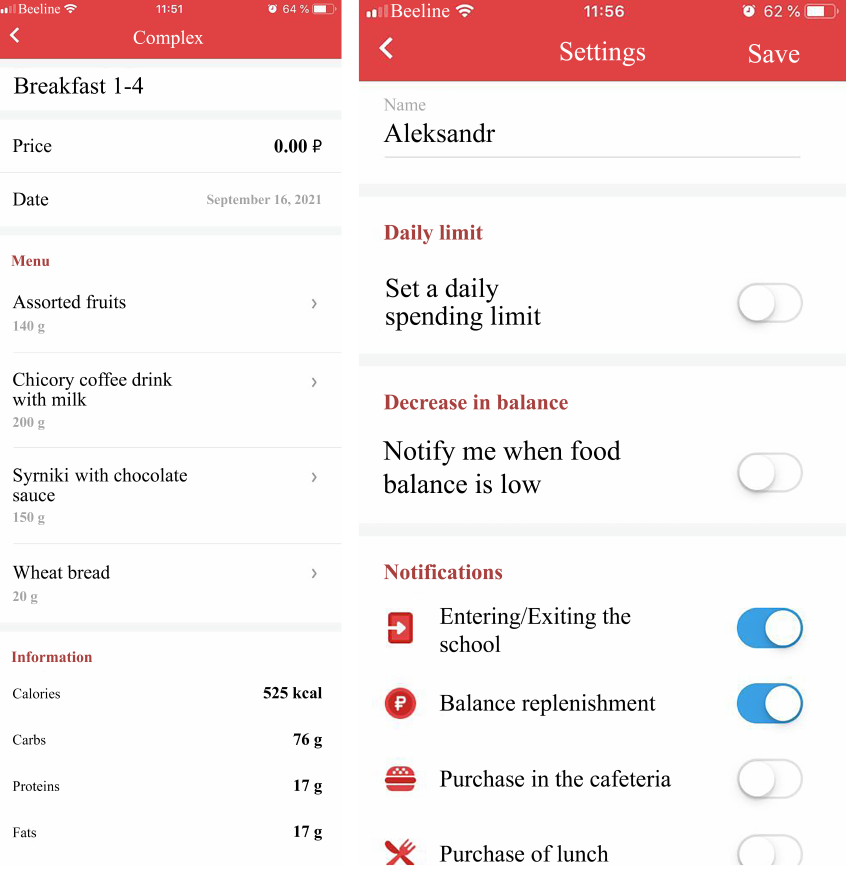
Figure A3. Examples of free hot meals for schoolchildren at elementary school (second grade of a public school in Moscow) in the “Moy rebenok v shkole” interface (section “Attendance and Meals”) of the application Gosuslugi Moscow. Source: compiled by the authors based on